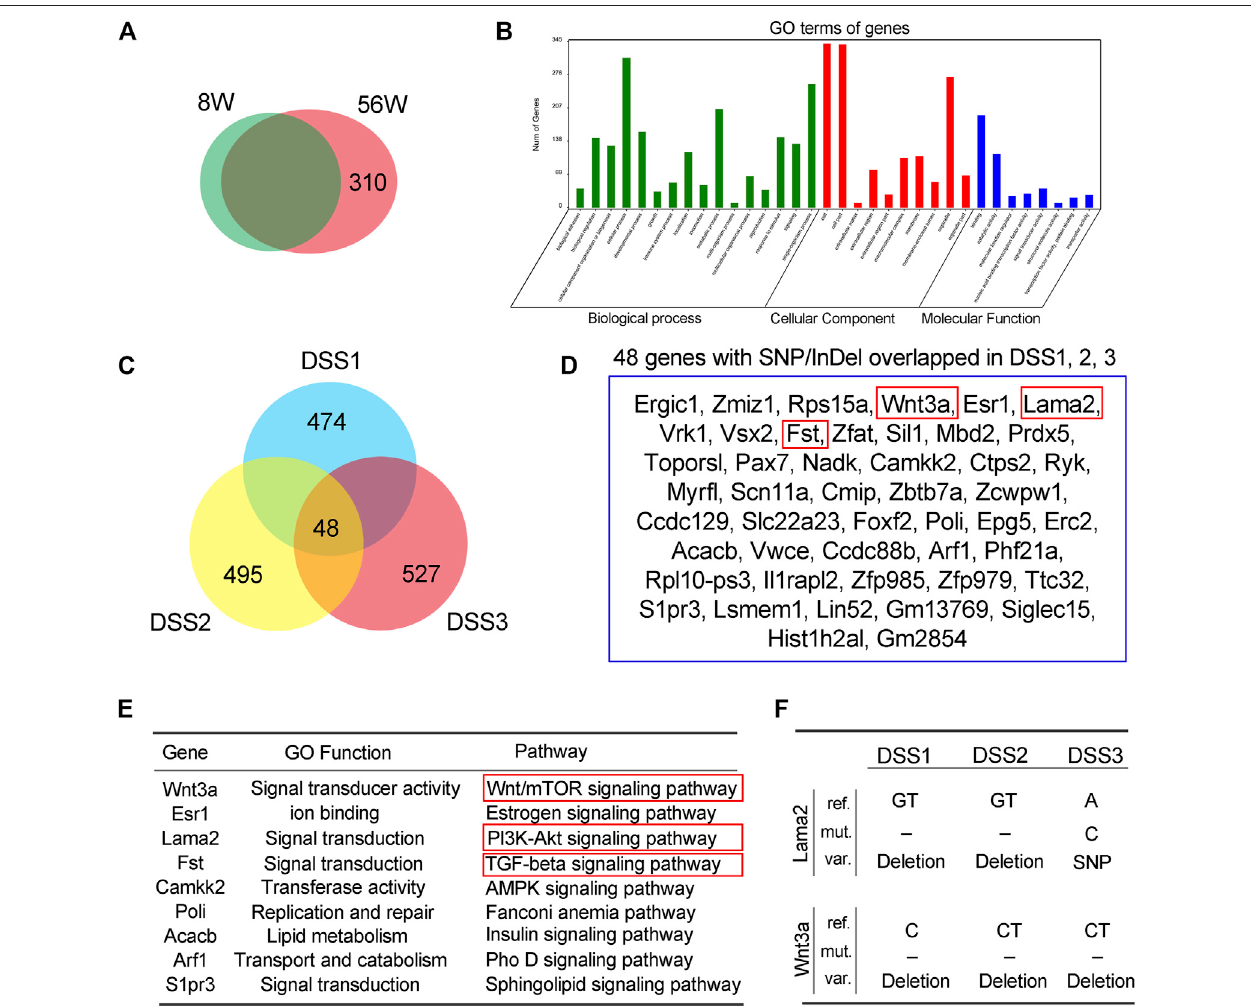
FIGURE3| Annotationofsingle-nucleotidepolymorphism/insertionordeletion(SNP/InDel)accumulatedintheoldanddextransulfatesodium(DSS)-treatedmice. (A) There were 310 SNP/InDel unique in 56W mice mucosa. (B) Gene Ontology (GO) enrichment showed that these genes were classi fi ed into the cellular function of biologicalprocess, cellular component,and molecularfunction. (C) There were 769/753/687 somatic (novel) SNP/InDel in thethree colitis mice,and this SNP/InDel was annotated into 474/495/527 genes; among these genes from different mice, 48 genes were overlapped. (D, E) The 48 genes that were overlapped in three colitis mice. Among these 48 genes, Wnt3a, Lama2, and Fst exert signal transduction function in the Wnt/mTOR, PI3K – AKT, and TGF-beta signaling pathways, respectively. (F) Lama2 mutation among the three DSS-treated mice mucosa, two ofthem were GT deletion mutation, and the other was SNP, while all the Wnt3a mutations in three DSS-treated mucosa were deletion